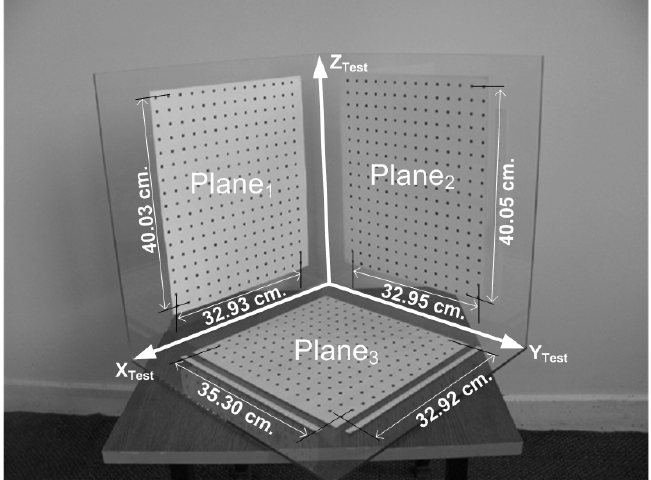
Figure 3. The Test Object used for performance measurement of the mentioned methods.